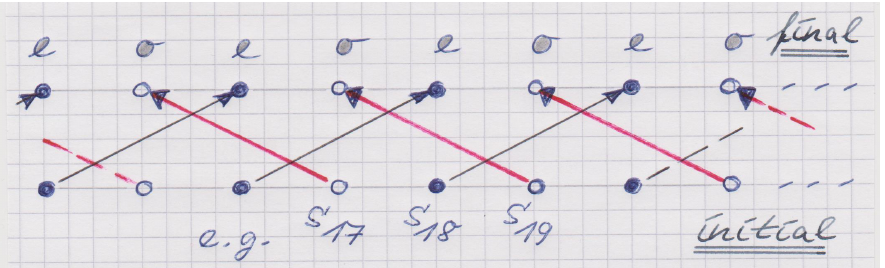
Figure 2. One-step update by ˆ U , Equation(11), of a piece of an initial spin chain state ( bottom ), cf. Equation(12). The state of a spin on site k , s k , jumps two sites to the left ( right ) if k is odd (even), which produces the final state ( top